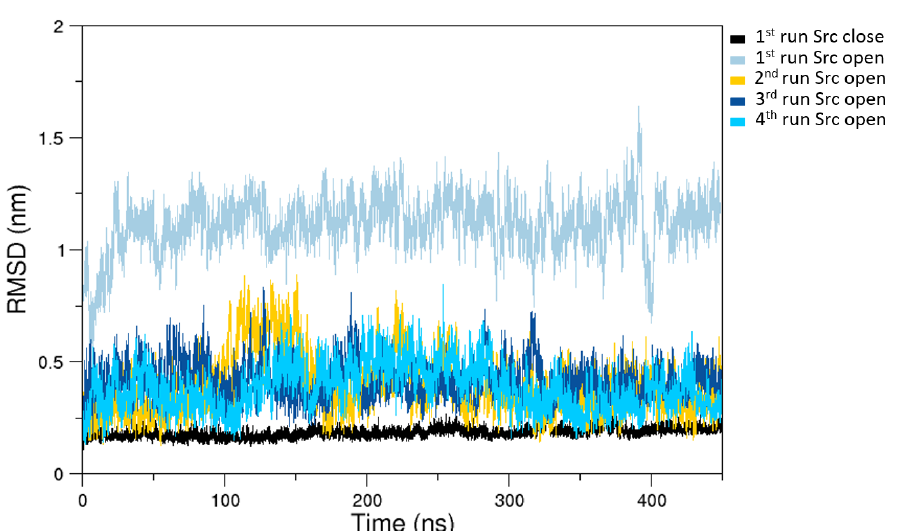
Figure 2. C- α RMSDs (Root Mean Square Deviations) computed on the last 400 ns of selected MD trajectories. In black is the closed state RMSDs and in colors (according to the label) are the open states RMSDs as obtained from a subset of representative MD trajectories.